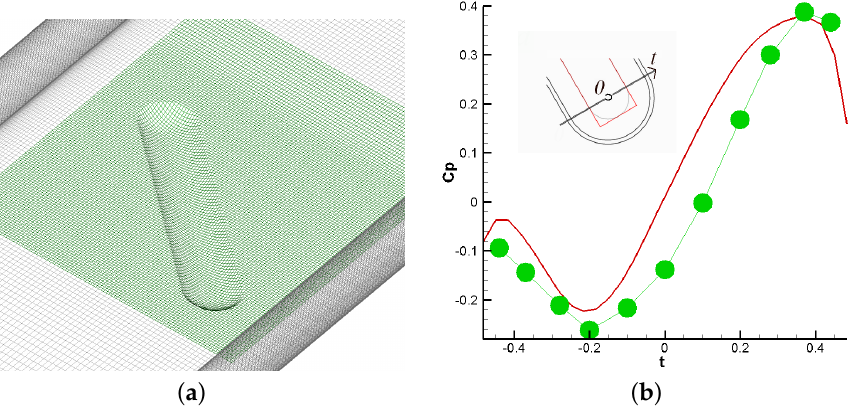
Figure 2. Two-part block grid ( a ) and comparison of the dependences of the static pressure coefficient ( b ) in the joint section of the dimple (line—calculation; dots—experiment